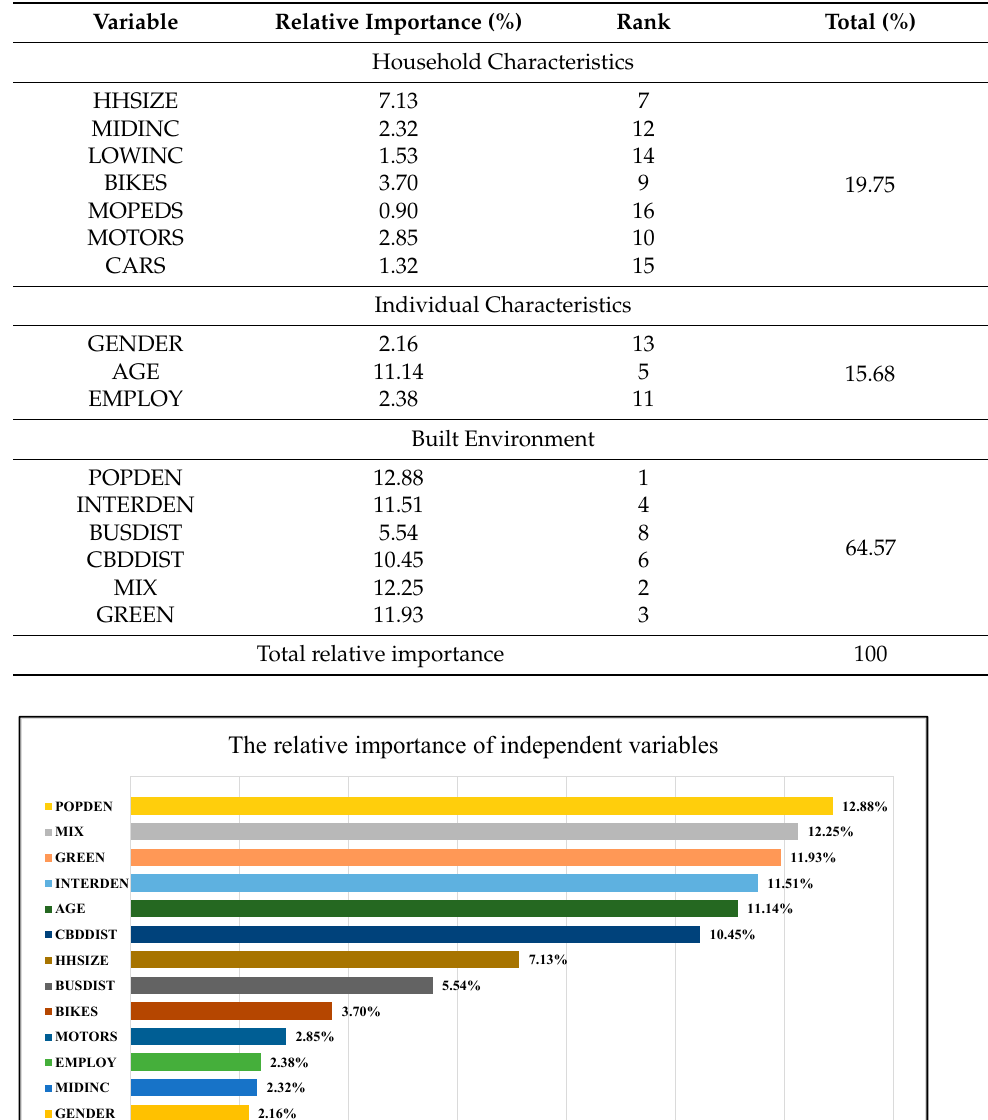
Table 5. The relative importance of independent variables.